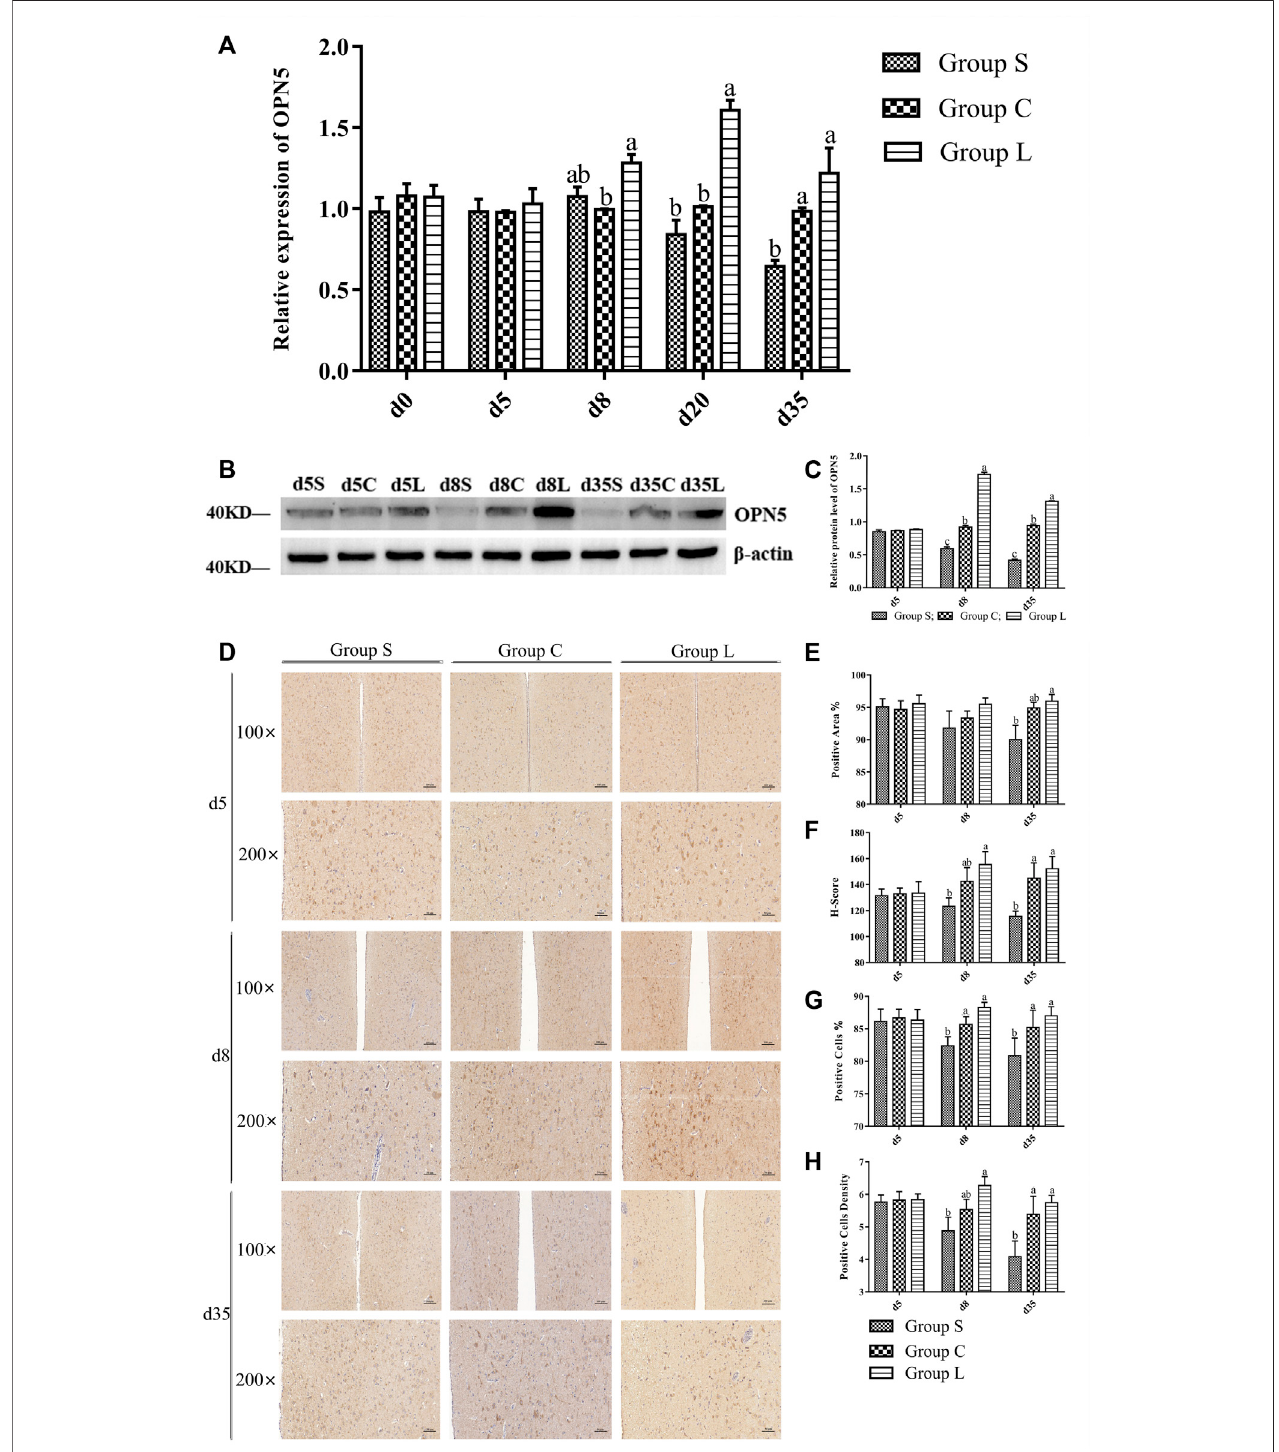
FIGURE 4 | OPN5 expression levels of protein and gene of mountain ducks under different photoperiods. (A) , the gene expression of OPN5; (B) , Western Blot results of relative protein levels of OPN5; (C) , changes in the protein expression of OPN5; (D) , the immunohistochemical staining images of OPN5; (E – H) were quantitative analysis of the immunohistochemical results of OPN5, indicating the analysis results of positive area, H-Score, positive cells, and positive cells density, respectively